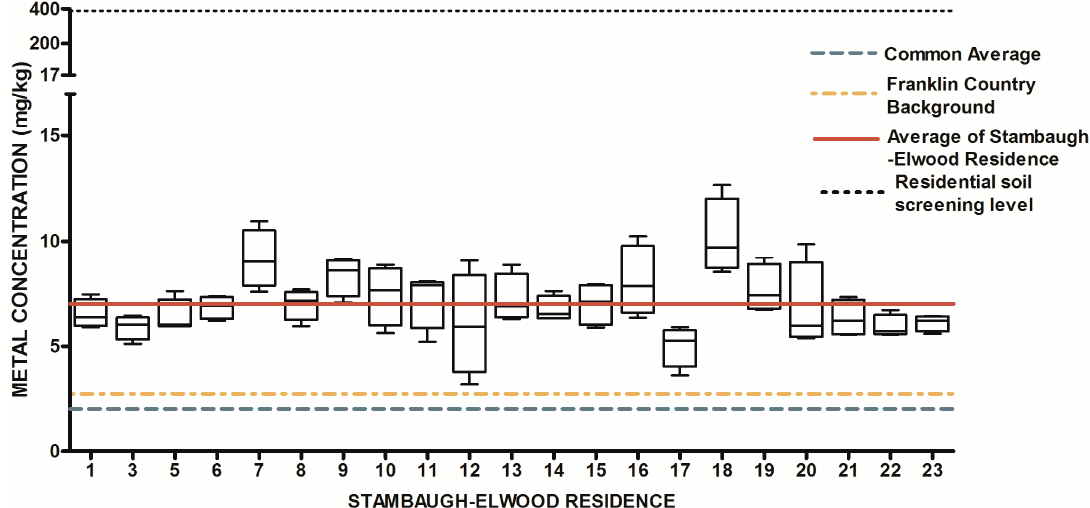
Figure 10. Residential urban soil level of Mo in the Stambaugh-Elwood community versus Franklin County (background), common averages and residential screening levels (RSLs) (mg/kg soil). Soil samples were taken from 21 of 46 residences that consented for the study in compliance with OSU IRB Protocol 2014B0445-exempt. Each sample consisted of four subsamples. Analysis proceeded following EPA Method 3051A, and digests were subsequently analyzed for metals using an Agilent